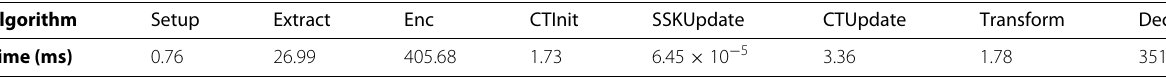
Table 3 Performance evaluation of the proposed mechanism Algorithm